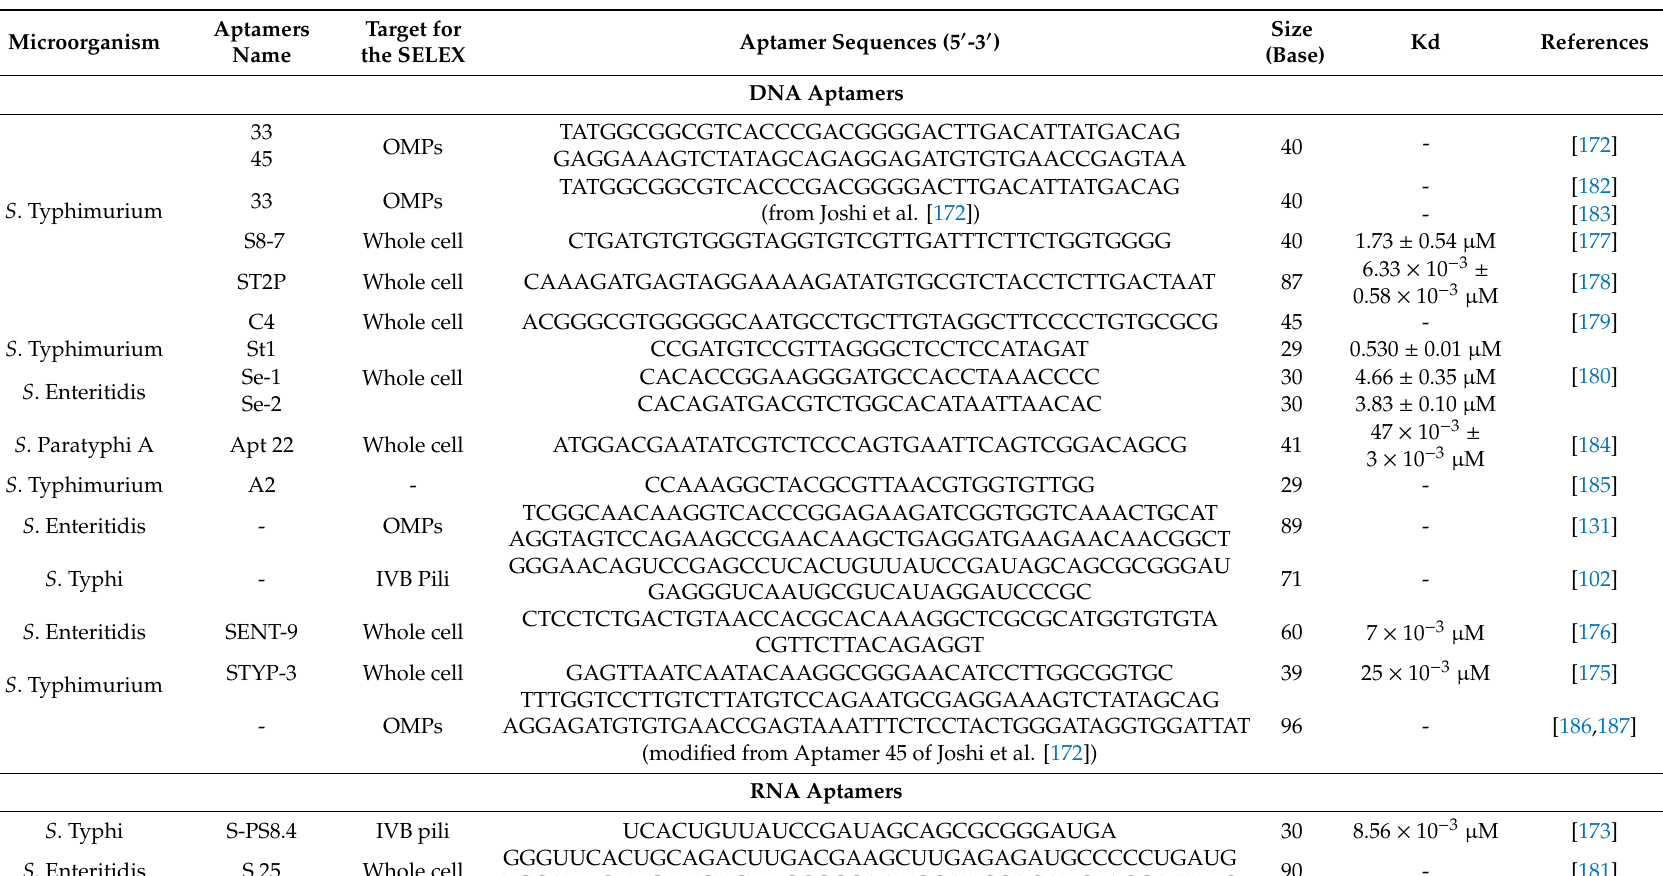
Table 4. Aptamers selected against Salmonella strains by the SELEX